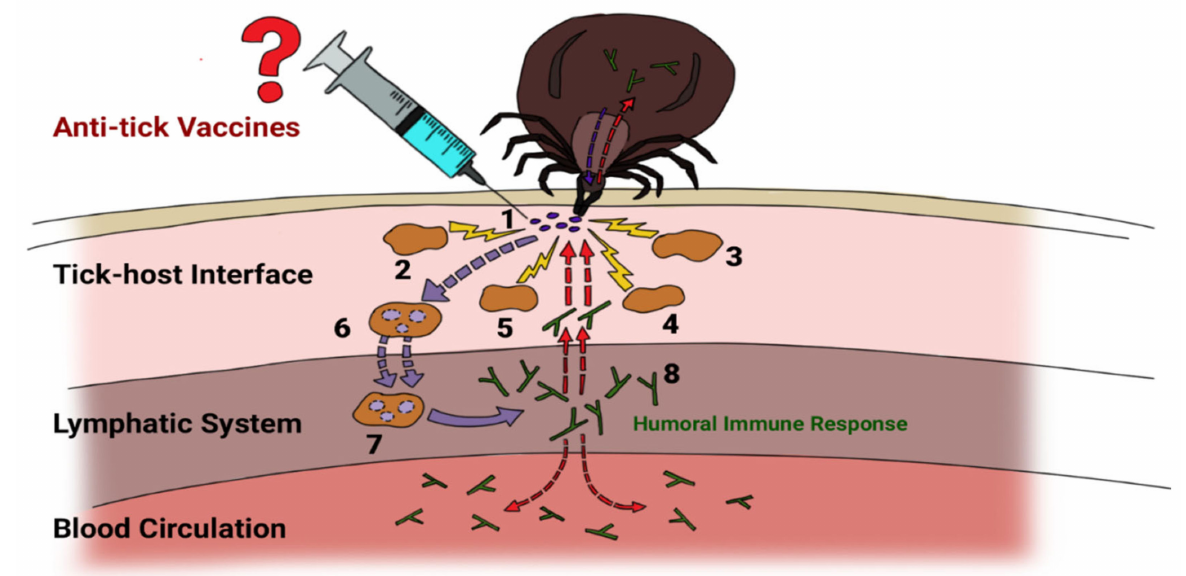
Figure 1. Tick-induced immune response: During feeding, ticks inoculate salivary proteins (1) which trigger recruitment of (2) antigen presenting cells (APC) which include macrophages and dendritic cells, (3) granulocytes which include neutrophils, basophils and eosinophils, (4) mast cells, (5) cytokines [16–20]. Salivary proteins are taken up by APCs (6), carried via the lymphatic system and presented to the lymph nodes to (7) induce a humoral immune response: antibody production (8). The antibodies move through the blood circulation and to the tick feeding